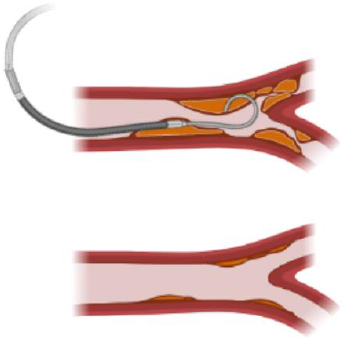
Figure 4. Secondary patency in TEVGs is achieved by the intervention of the graft by removing the clot with a catheter. This recuperates the lumen of the graft and allows perfusion, giving the graft a second opportunity to allow the initiation of regeneration processes without hemodynamic impairments (Created with BioRender.com, accessed on 3 February 2022).